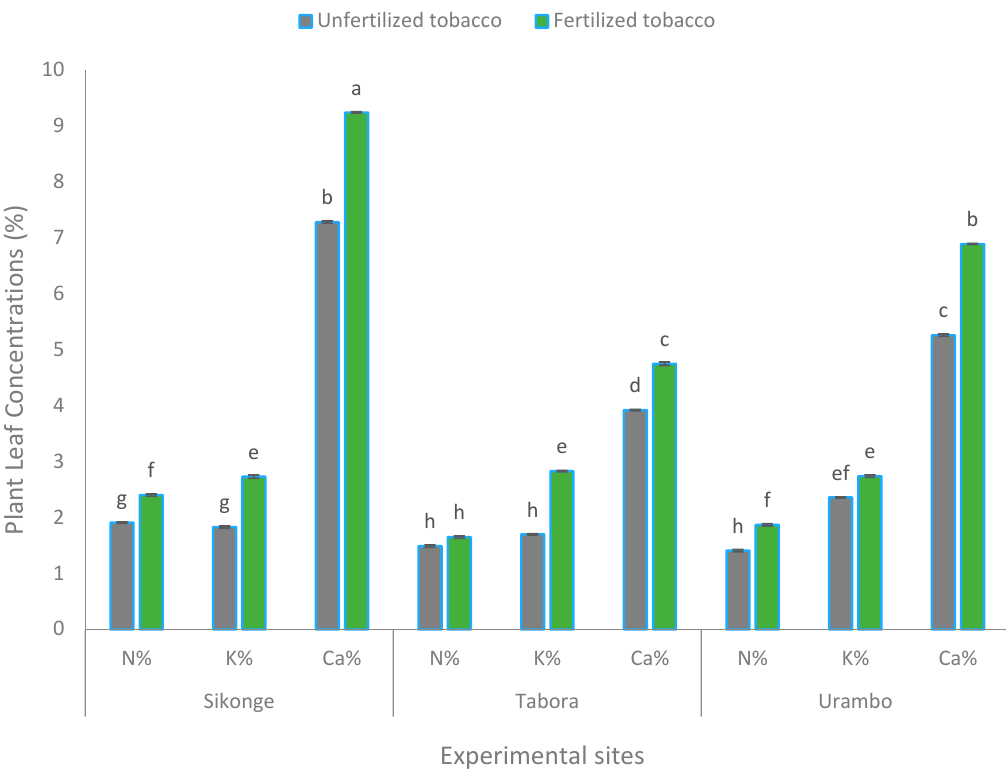
Figure 8. Plant leaf N, K, and Ca concentrations upon fertilization across the sites. ‘a’ is very highly significant; ‘b’ is highly significant; ‘c’ ‘d’ ‘e’ & ‘f’ are significant; ‘g’ & ‘h’ non